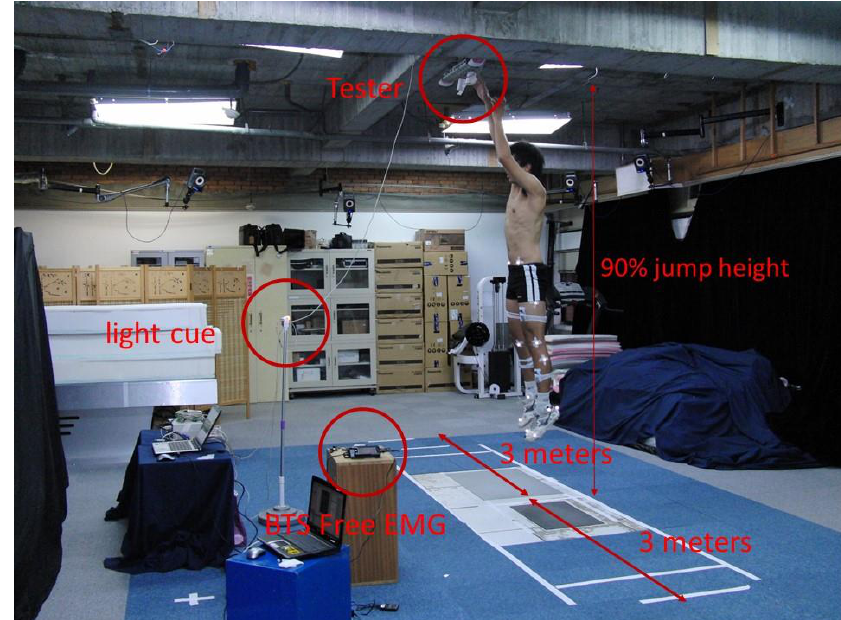
Figure 1. Diagram and explanation of the blocking agility test for volleyball. The athlete was required to perform a total of 14 blocks from two directions. The blocking agility test system and wireless electromyography (BTS Free EMG) were set in the front of the athlete.